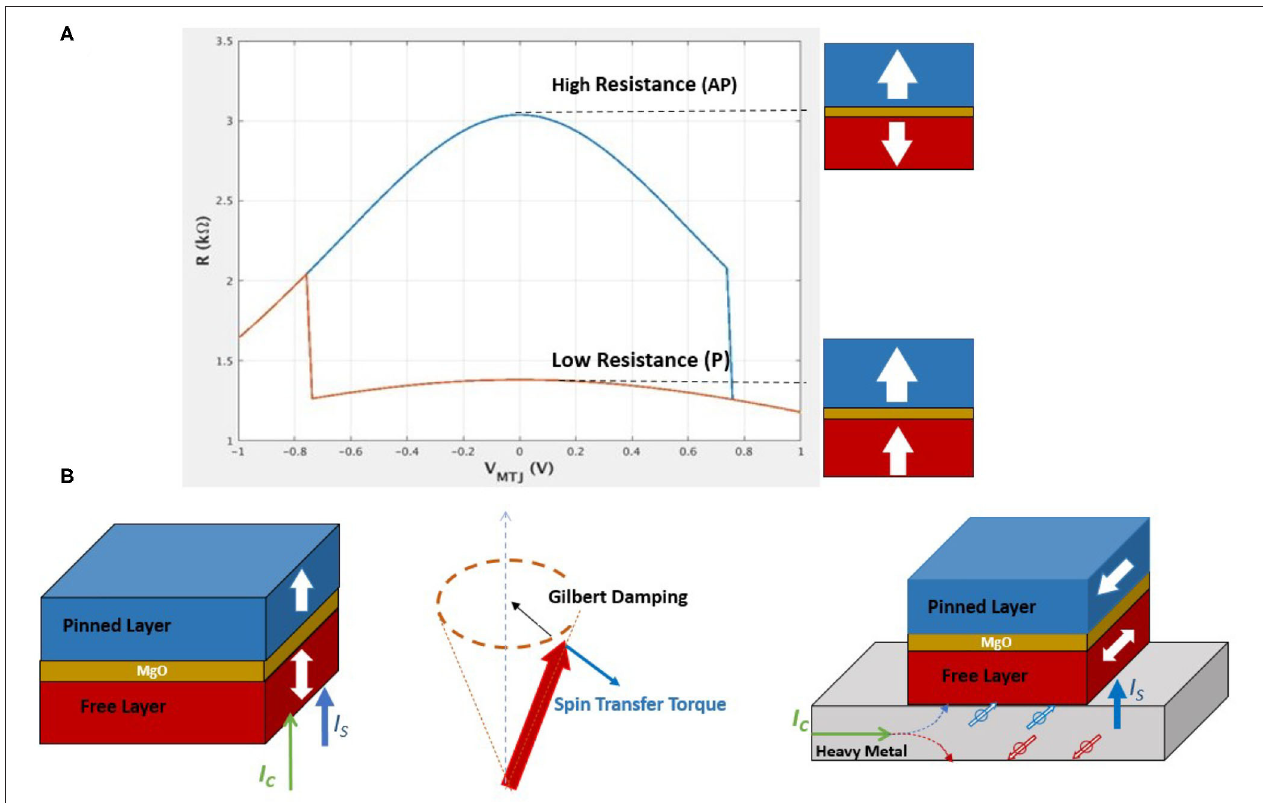
FIGURE 2 | (A) Magnetic tunnel junction (MTJ) and tunneling magnetoresistance (TMR). Resistance of MTJ depends on the relative orientations of the two ferromagnetic layers next to the tunnel barrier. High/low resistance states correspond to anti-parallel (AP)/parallel (P) configuration of the magnetic ordering in the free layer and reference layer. (B) Spin transfer torque (STT) and spin-orbit torque (SOT). STT is originated from spin polarized current going through an MTJ. The STT effectively switches spins by countering against the Gilbert damping of the free layer magnetic moments. SOT is a result of spin Hall effect at interface of ferromagnetic/heavy metal layers, where a charge current flowing along the heavy metal layer can induce a transverse spin current flowing into the adjacent ferromagnetic